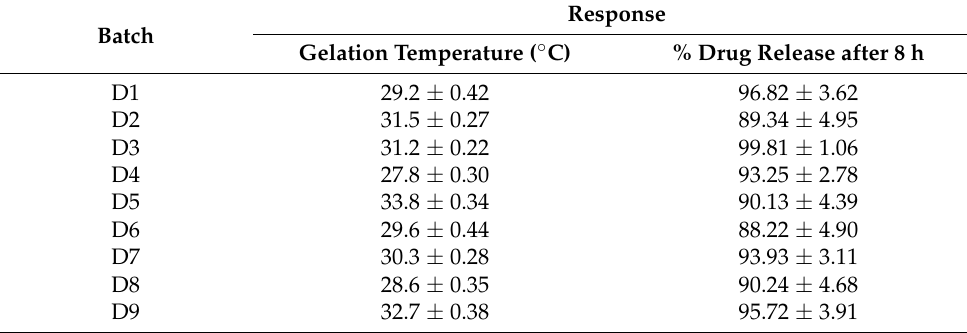
Table 3. Responses of 3 2 full factorial design